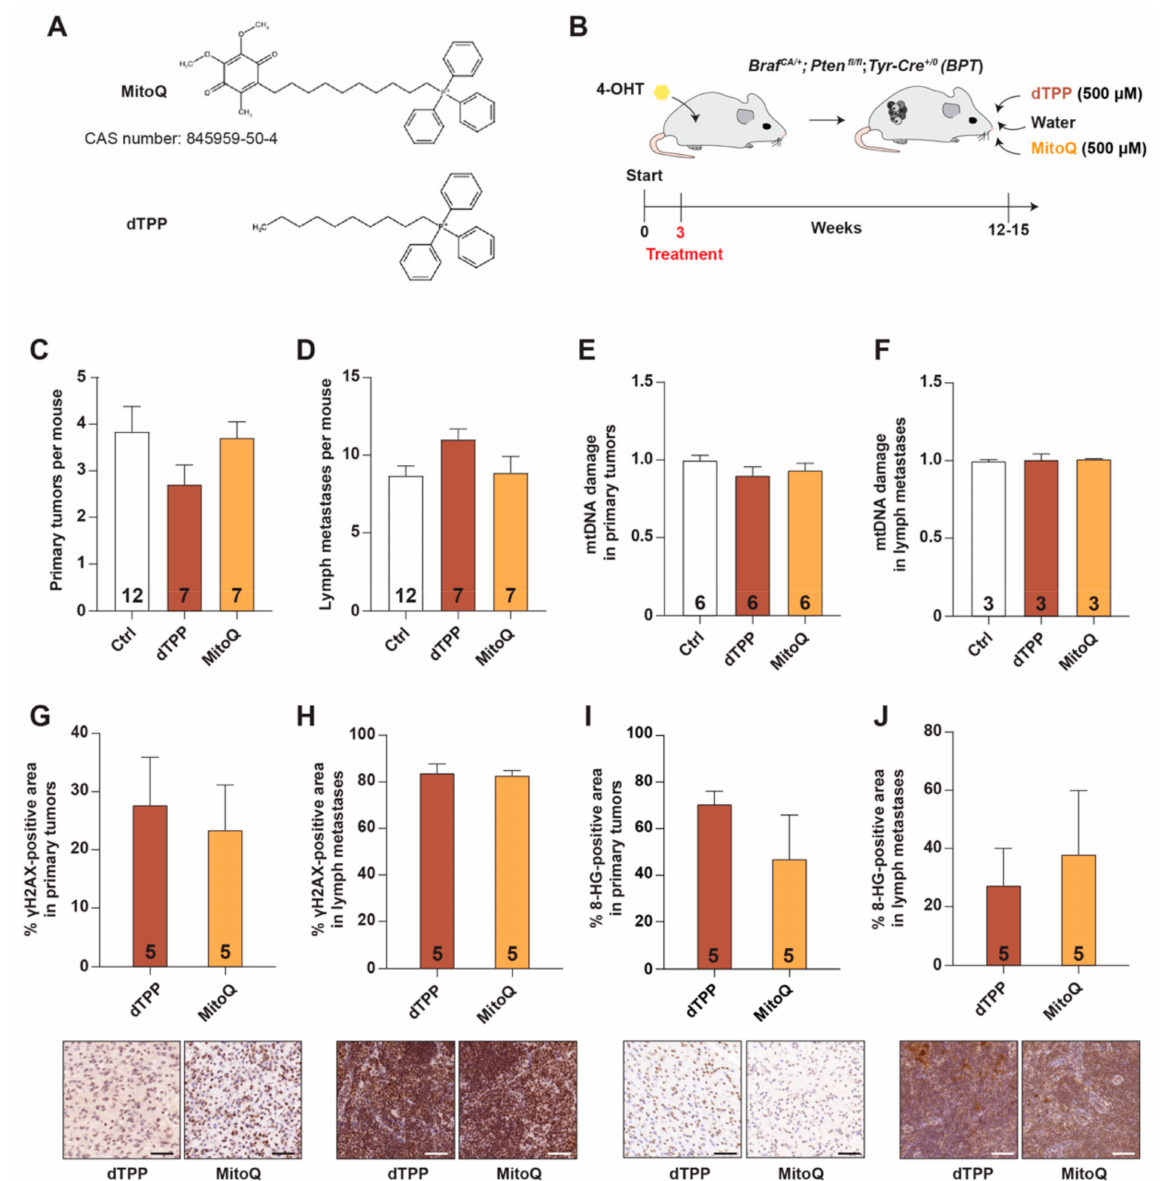
Figure 1. The mitochondria-targeted antioxidant MitoQ does not influence malignant melanoma progression in mice. ( A ) Structure of MitoQ and its control substance dTPP. ( B ) Schematic showing how two-day-old Braf CA/+ Pten fl/fl Tyr-Cre +/0 mice (designated BPT mice) were painted with 4-hydroxytamoxifen on the flank skin to activate BRAF V600E expression and inactivate PTEN expression in melanocytes (start). dTPP and MitoQ were administered in the drinking water to newly-weaned mice (3 weeks). ( C ) Number of primary tumors in BPT mice administered regular water (Ctrl), dTPP, or MitoQ. ( D ) Number of lymph node metastases in BPT mice administered regular water (Ctrl), dTPP, or MitoQ. ( E , F ) Quantification of mitochondrial DNA (mtDNA) damage in primary tumors ( E ) and lymph node metastases ( F ); data are normalized to Ctrl. ( G , H ) Top, percent H2AX-positive area in primary tumors ( G ) and lymph node metastases ( H ). Bottom, representative photographs of H2AX-stained sections. ( I , J ) Top, percent 8-HG-positive area in primary tumors ( I ) and lymph node metastases ( J ) of dTPP- and MitoQ-treated BPT mice. Bottom, representative photographs of 8-HG-stained sections. Numbers in bars = n . Scale bars = 50 µ